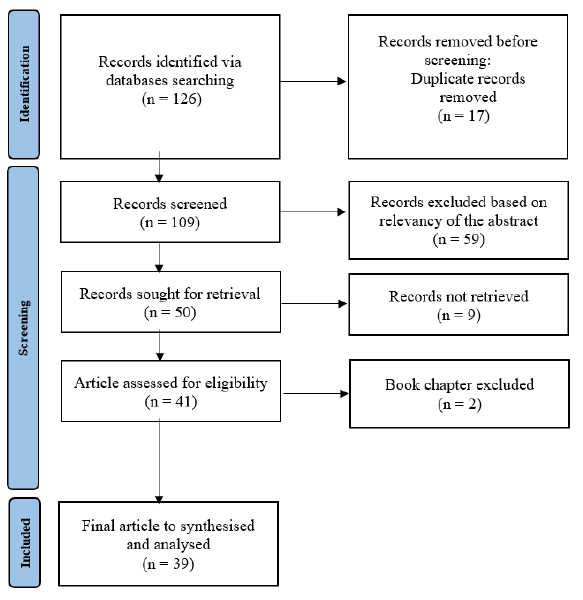
Figure 1 . PRISMA flow diagram for the literature search.